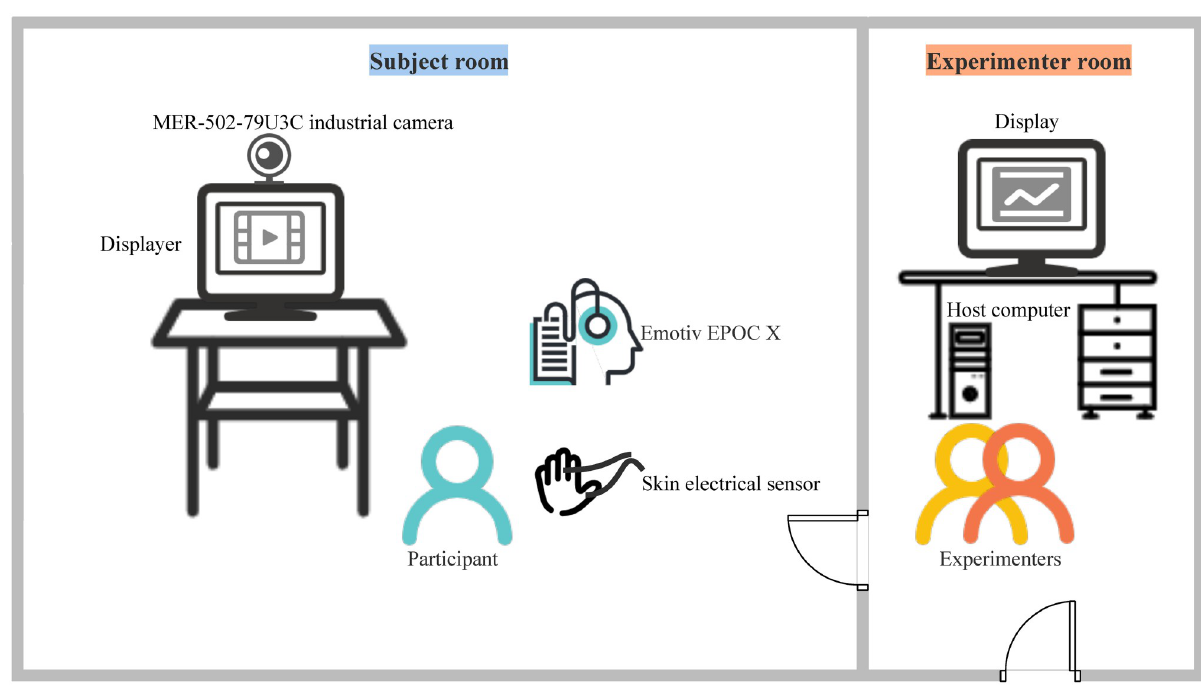
Fig 9. The experimental